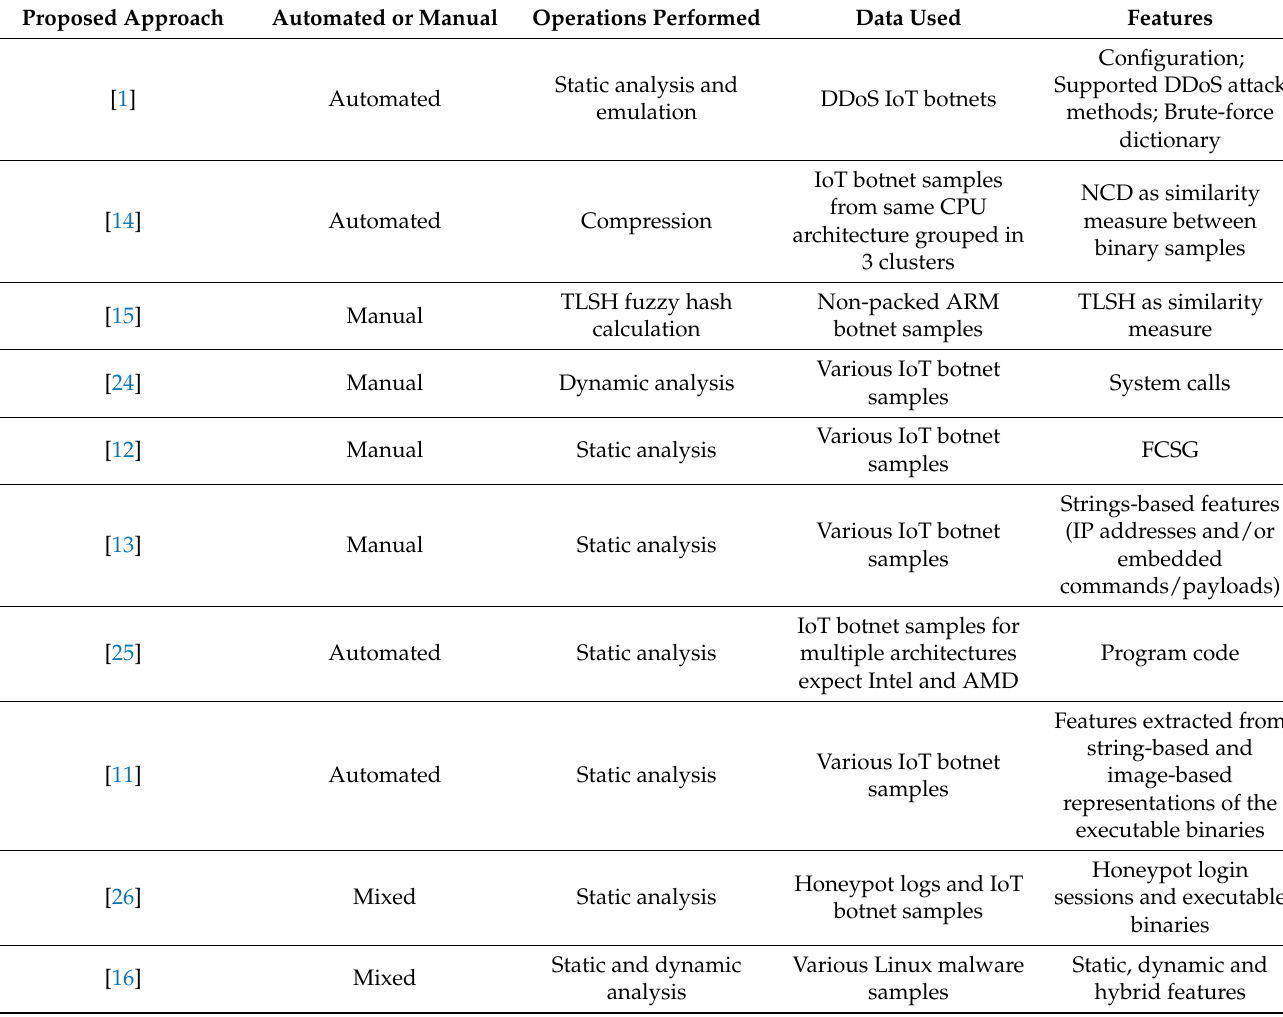
Table 1. Related work concerned with the clustering of IoT